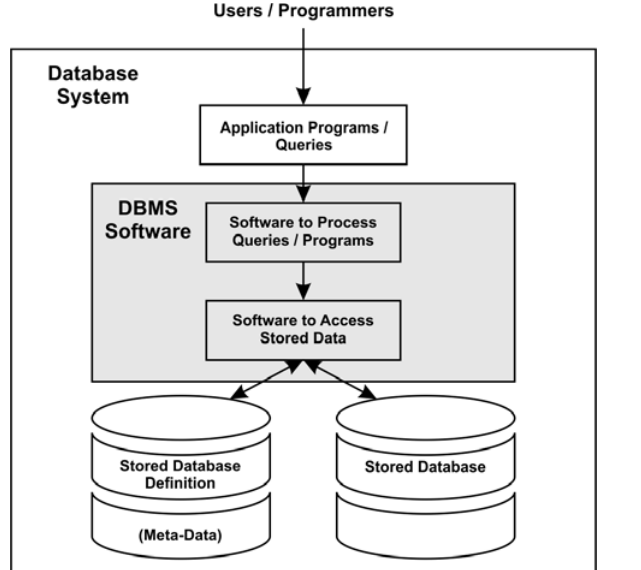
Figure 1 – Simplified database